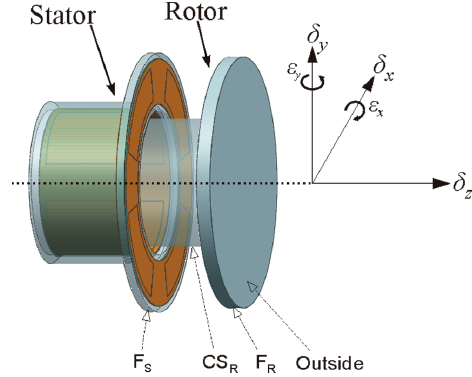
Figure 1. Schematic of T-type CS.